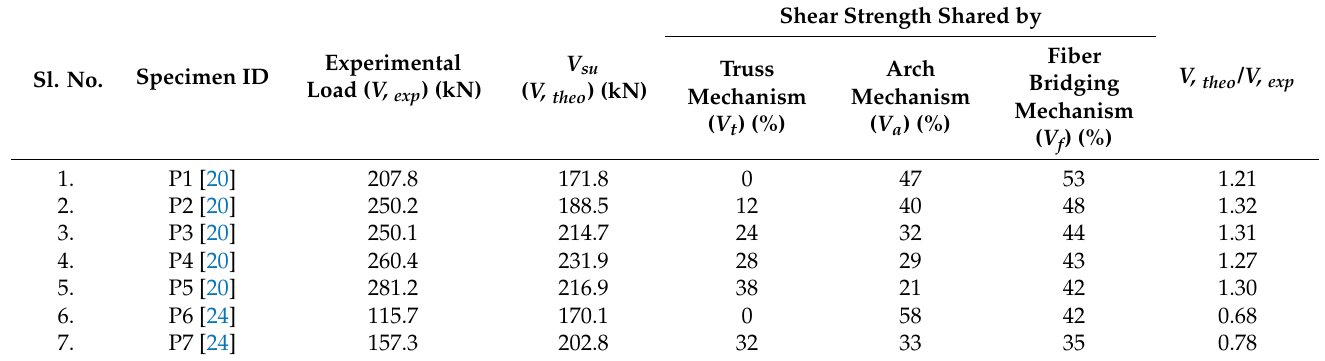
Table 5. Summary of predicted ultimate load-carrying